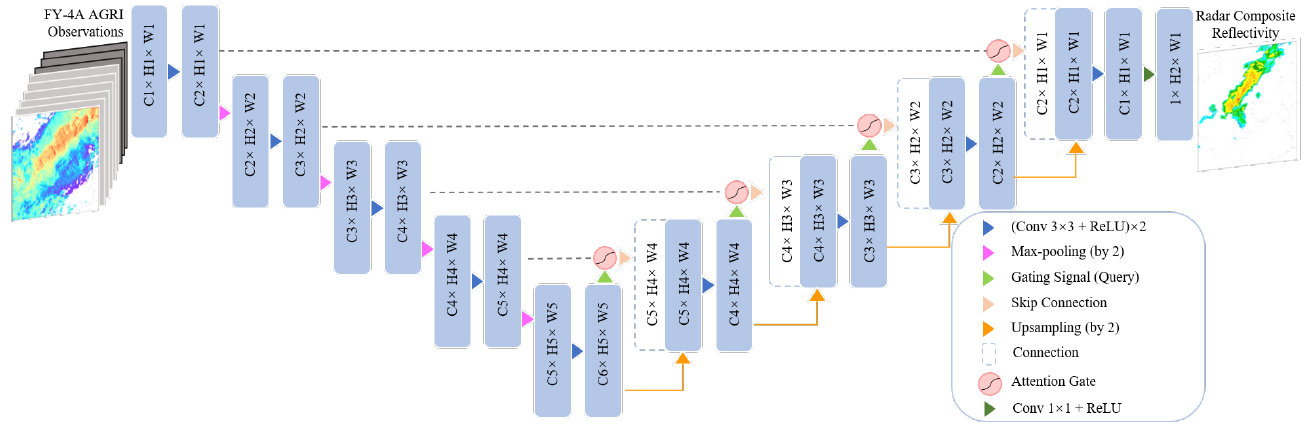
Figure 4. Strcucture of Attention